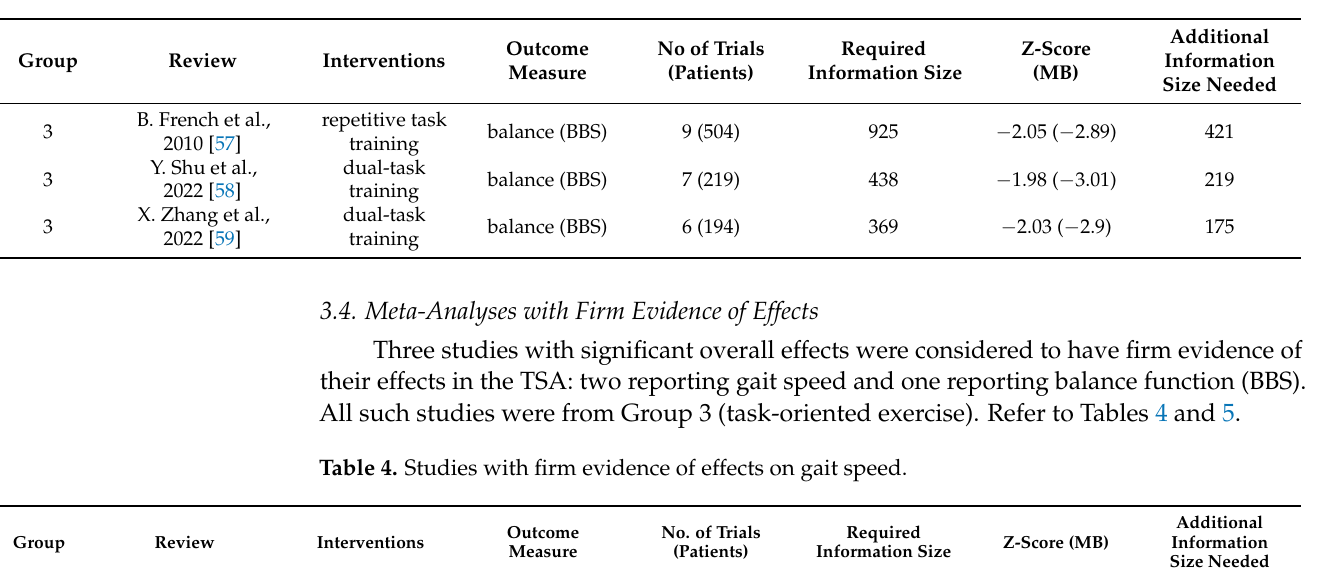
Table 3. Studies with potentially spurious evidence of an effect on balance function (BBS).